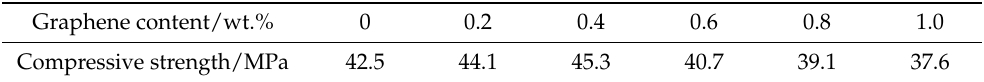
Table 5. Compressive strength of graphene composite conductive concrete with different graphene content at 28 d age.